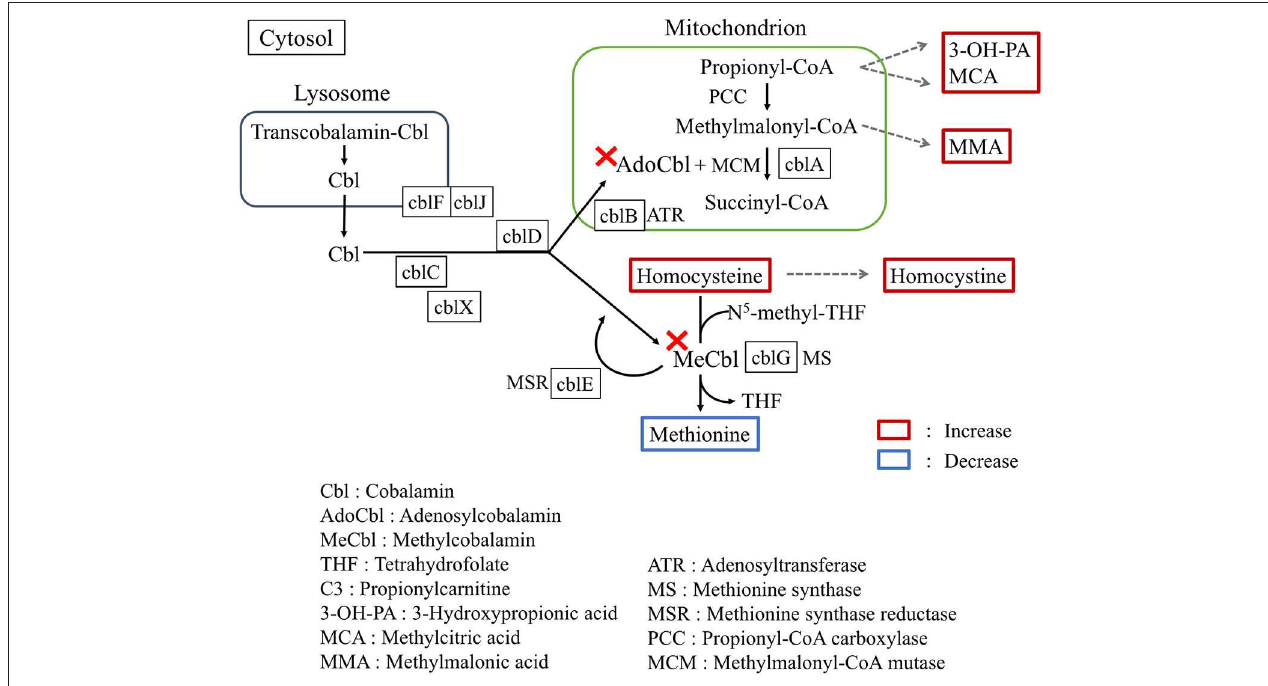
FIGURE 2 | Summarized pathways involving cobalamin metabolism. The map shows the metabolic consequences of vitamin B12 deficiency.